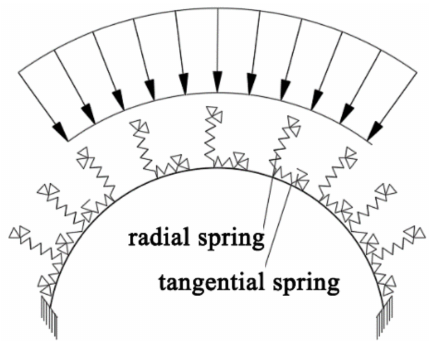
Figure 15. Schematic diagram of a local load-structure model of the rockburst